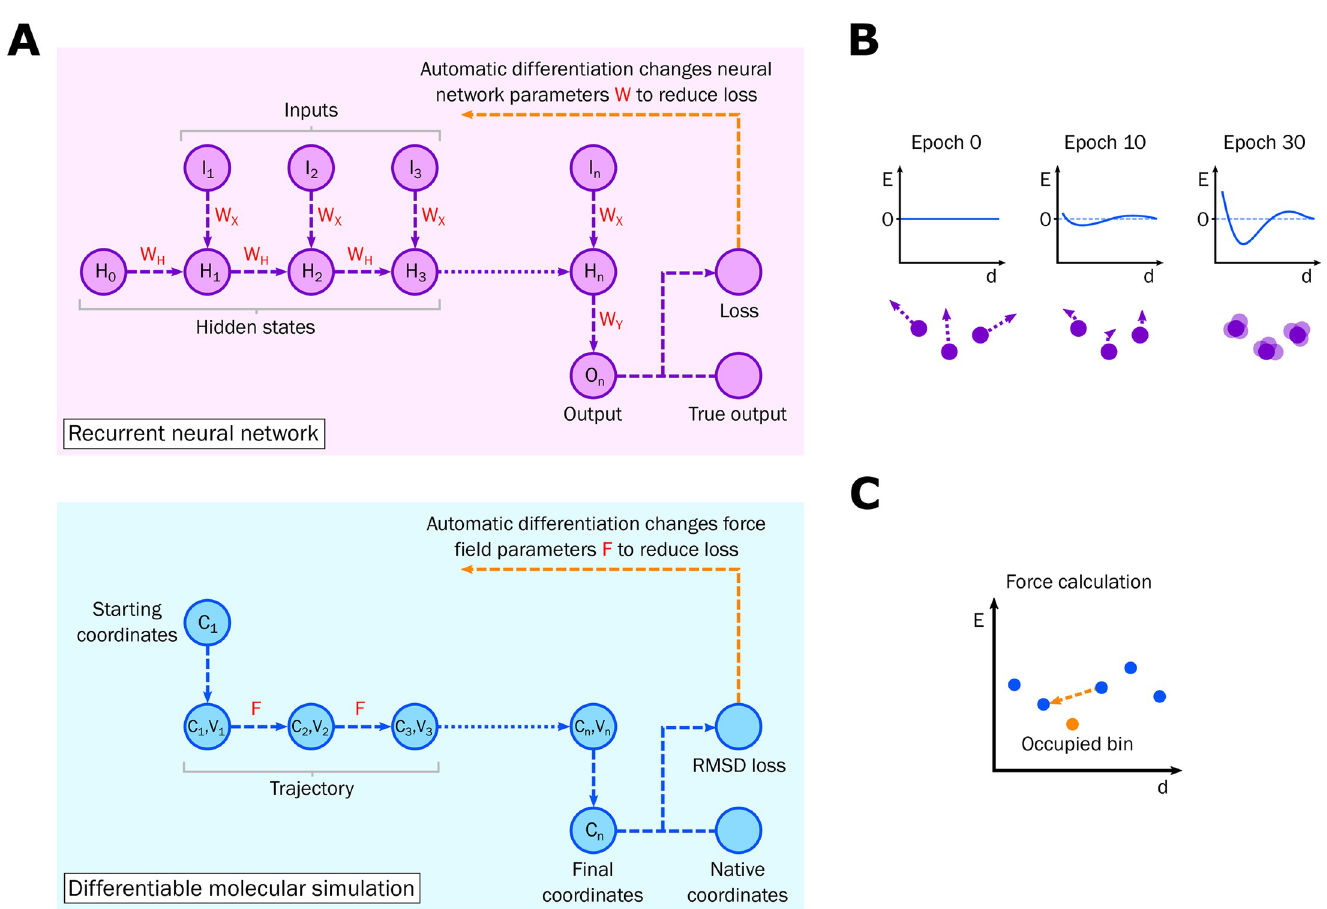
Fig 1. Differentiable molecular simulation. (A) The analogy between a RNN and DMS. Learnable parameters are shown in red. The same parameters are used at each step. There are many variants of RNNs; the architecture shown here has a single output for a variable length input, which could for example represent sentiment classification of a series of input words. (B) Learning the potential. A representation of a component of the potential is shown with energy E plotted against inter- atomic distance d . At the start of training (epoch 0) the potential is flat and the atoms deform according to their starting velocities. During training the potential learns to stabilise the native structures of the training set. (C) Force calculation from the potential. Adjacent bins to the occupied bin are used to derive the force using finite differences. In this case the force acts to reduce the distance d . See the methods for more details.